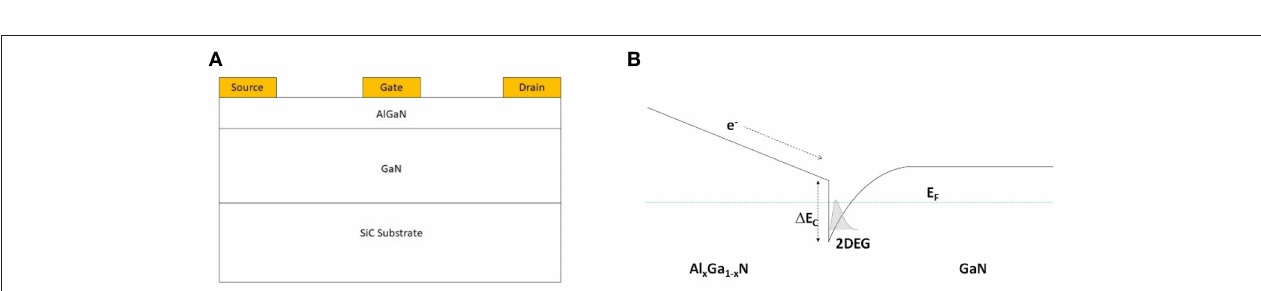
FIGURE 4 | (A) Schematic of a typical GaN HEMT cross-section showing a thin ( ∼ 20nm) AlGaN layer and a micron-thick GaN layer grown on top of a SiC substrate; (B) The energy band structure of AlGaN/GaN showing the formation of the two-dimensional electron gas (2DEG) at the interface.